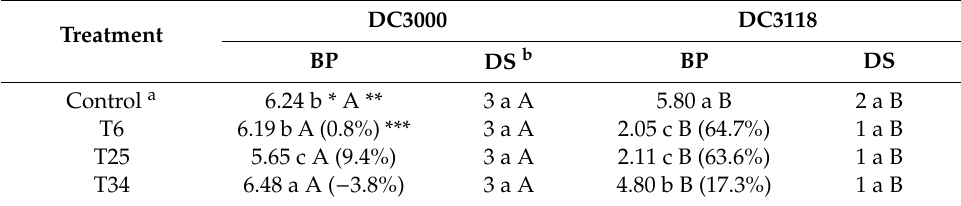
Table 1. Bacterial populations (BPs) and disease severity (DS) of P. syringae DC3000 and DC3118 strains in dip-inoculated tomato plants pre-treated with three Trichoderma species at 72 hpi of both bacterial strains.